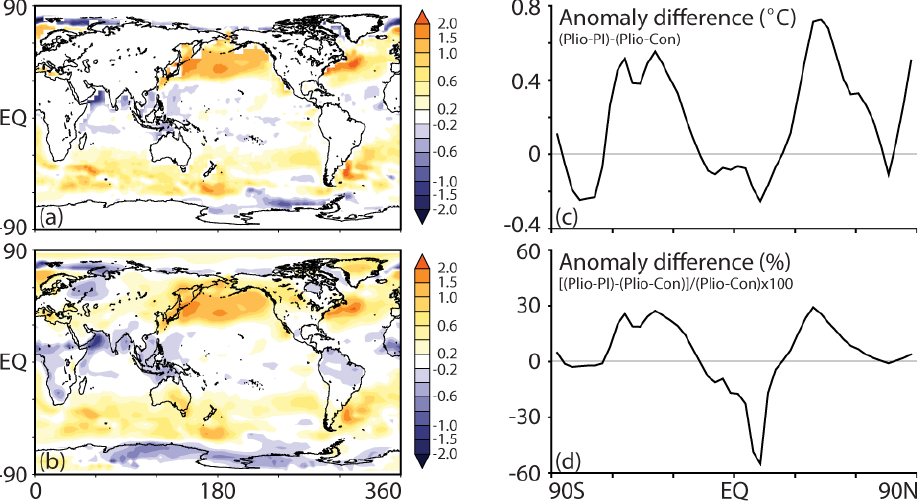
Fig. 8. Uncertainties in mid-Pliocene SAT anomalies introduced by the choice of the SST forcing. (a) Differences in annual mean SST between the local modern and the 1879–1900 HadISST. (b) Differences between the mid-Pliocene SAT anomalies relative to the pre- industrial and the mid-Pliocene SAT anomalies relative to the control experiment, Fig. 6a–d. (c) The zonal mean for (b) . (d) The percentage of the zonal mean difference in (c) , relative to the zonal mean SAT anomalies between the mid-Pliocene and the control